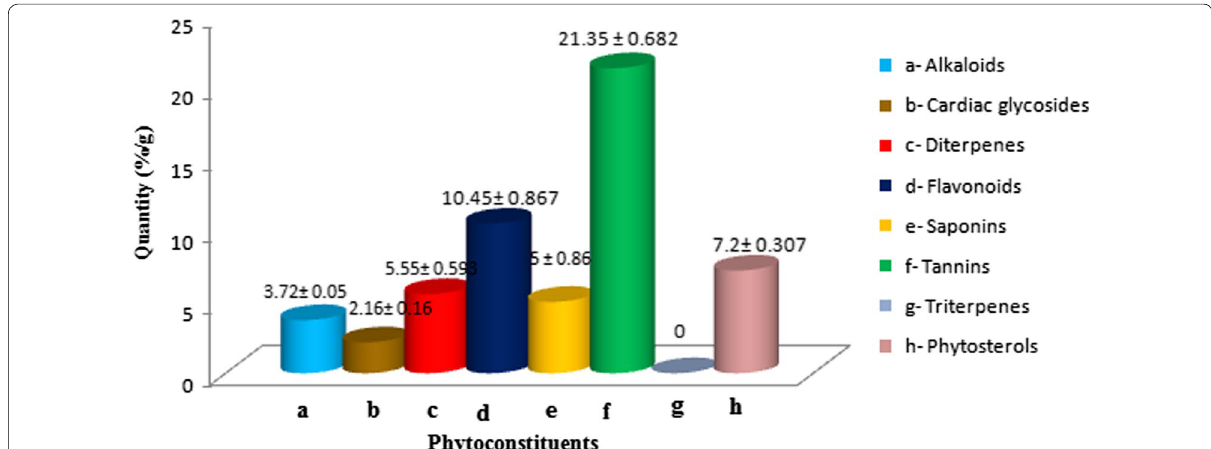
Fig. 1 The concentration of various phytoconstituents of Gymnema sylvestre leaves (%/g). *The values are expressed as Mean ** No significant difference was observed within values at 5% significance level as revealed by One-Way ANOVA